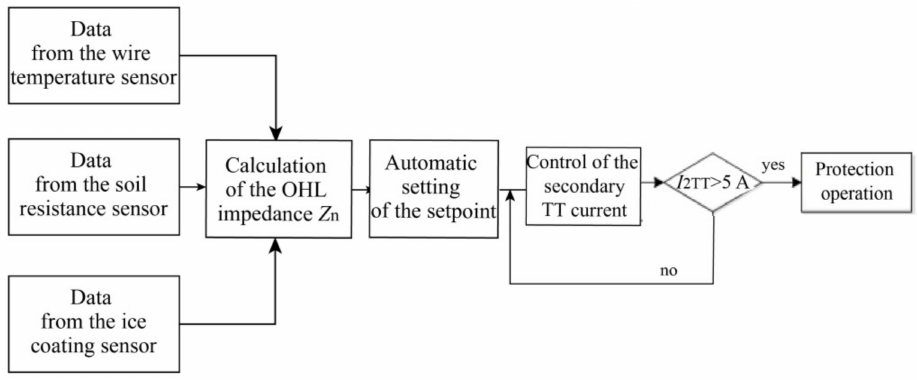
Figure 19. Algorithm of operation of distance protection with adaptive